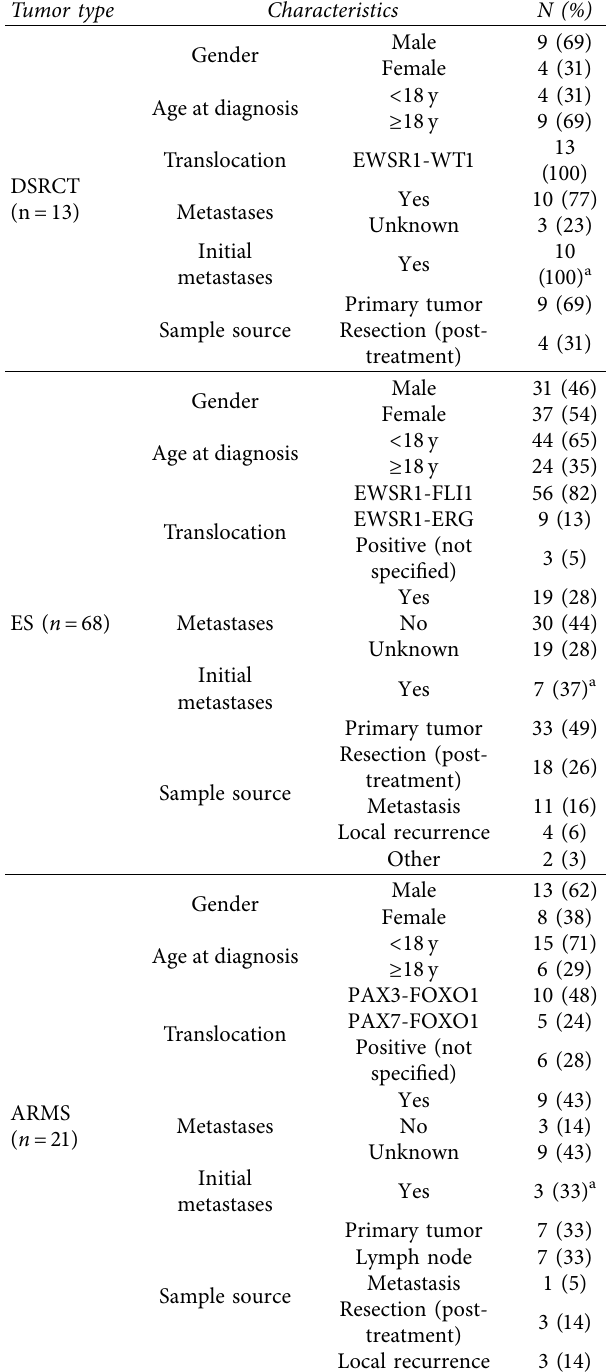
Table 1: Patient characteristics of ES, DSRCT, ARMS, and ERMS tumor tissue. Tumor